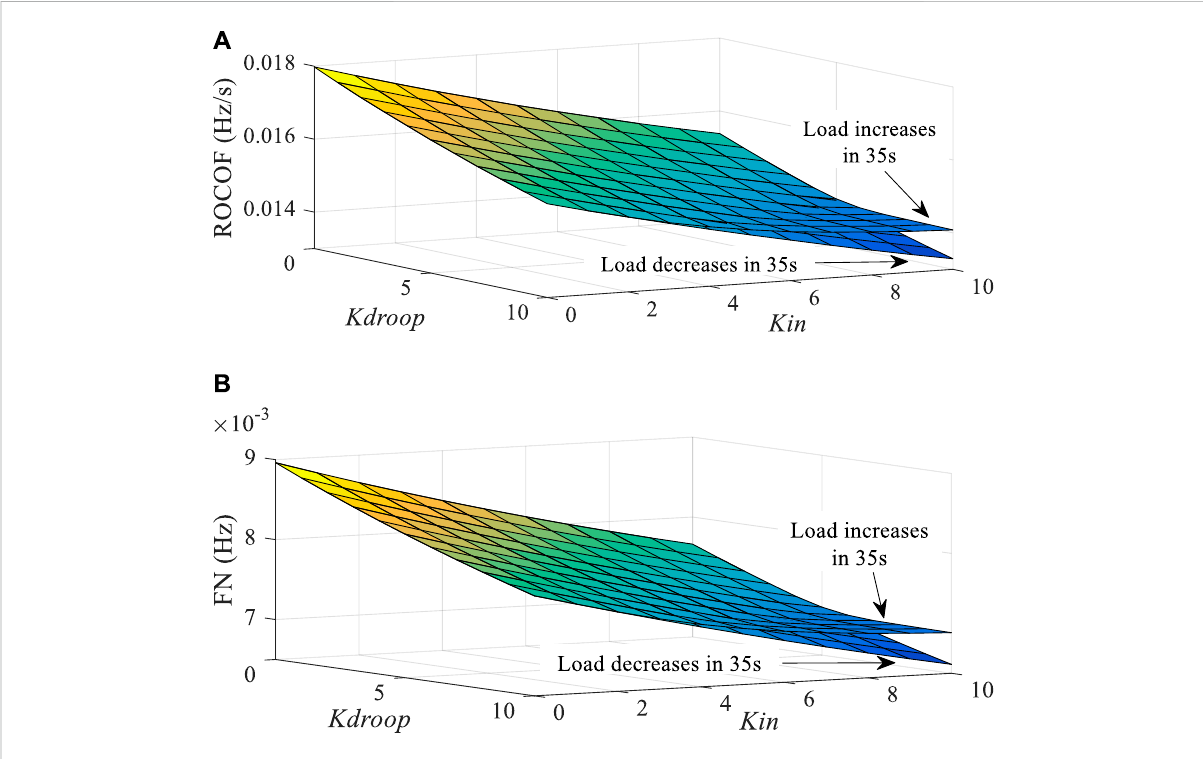
FIGURE 11 ROCOF and FN of the system. (A) ROCOF results under the change in K when the system load increases and decreases by 5% at 35 s. (B) FN results under the change in K when the system load increases and decreases by 5% at 35 s.